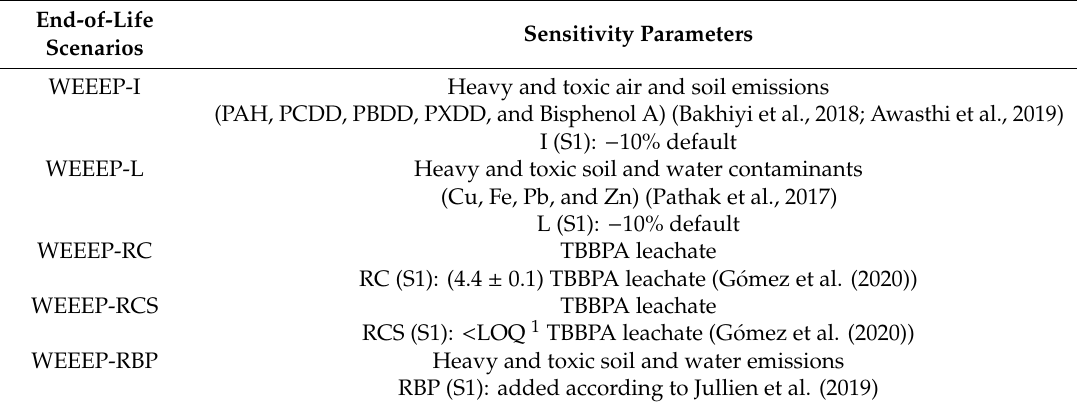
Table 6. Parameters used for the sensitivity